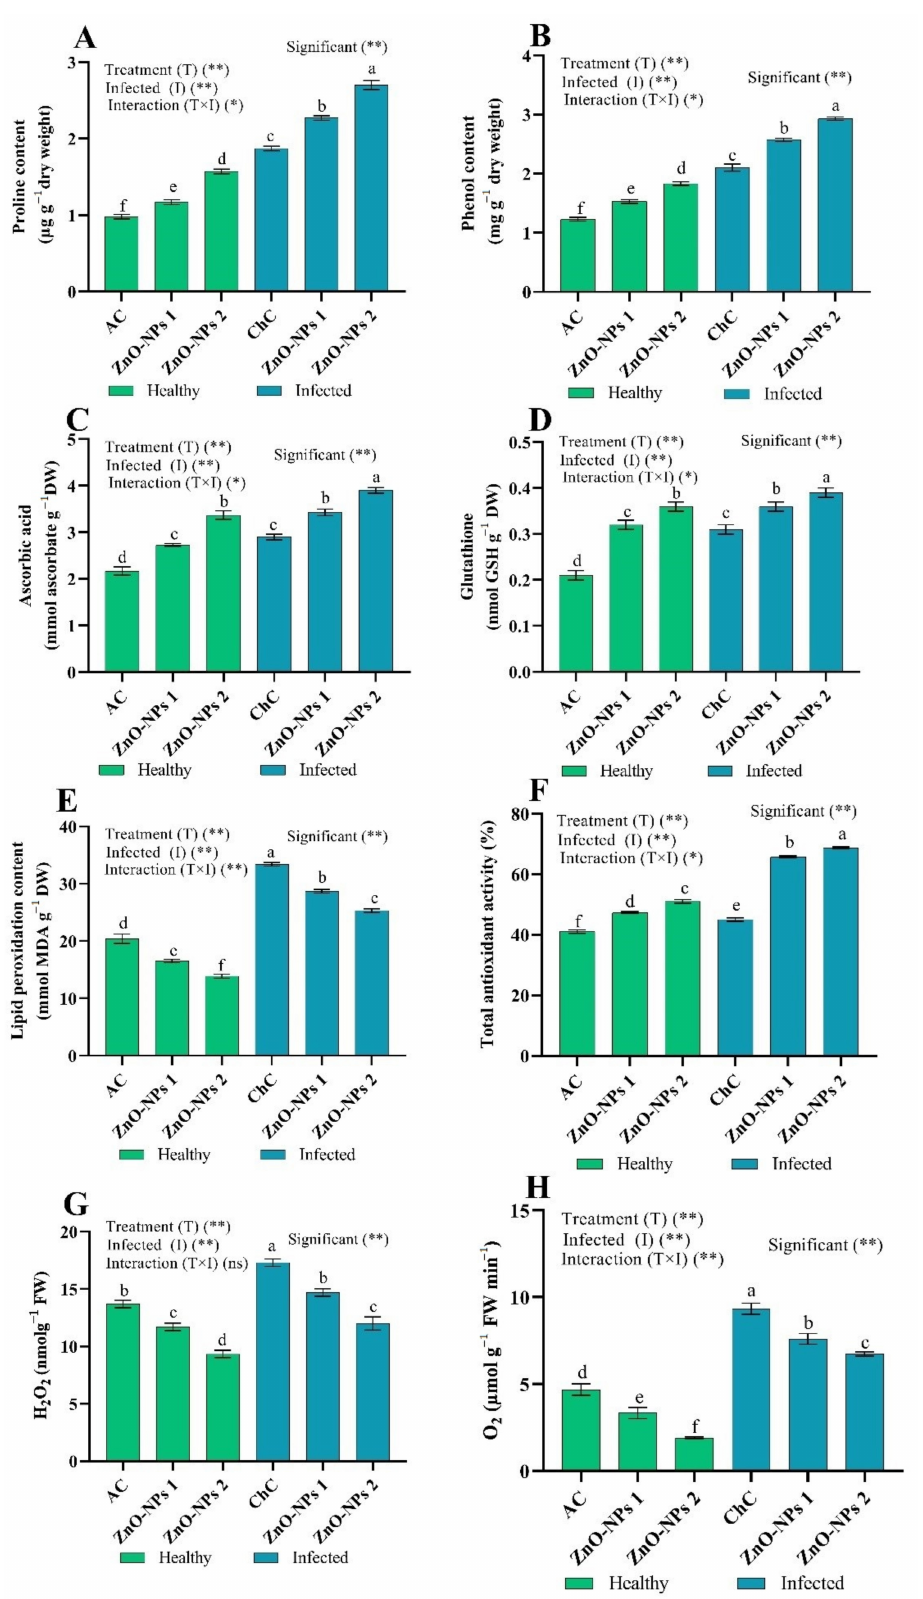
Figure 6. ( A – H ) Effect of foliar spray by ZnO-NPs1 (50 mg/L) and ZnO-NPs2 (100 mg/L) on tomato oxidative stress markers under absolute control (AC) and Tomato mosaic virus (ToMV) infection (ChC). According to the Fisher test, the different letters (a, b, c, d, e, f) are significantly different at 0.05%. Vertical bars represent the means of three independent determinations ± standard error (SE). * and ** suggest significant and highly significant differences. ns = not